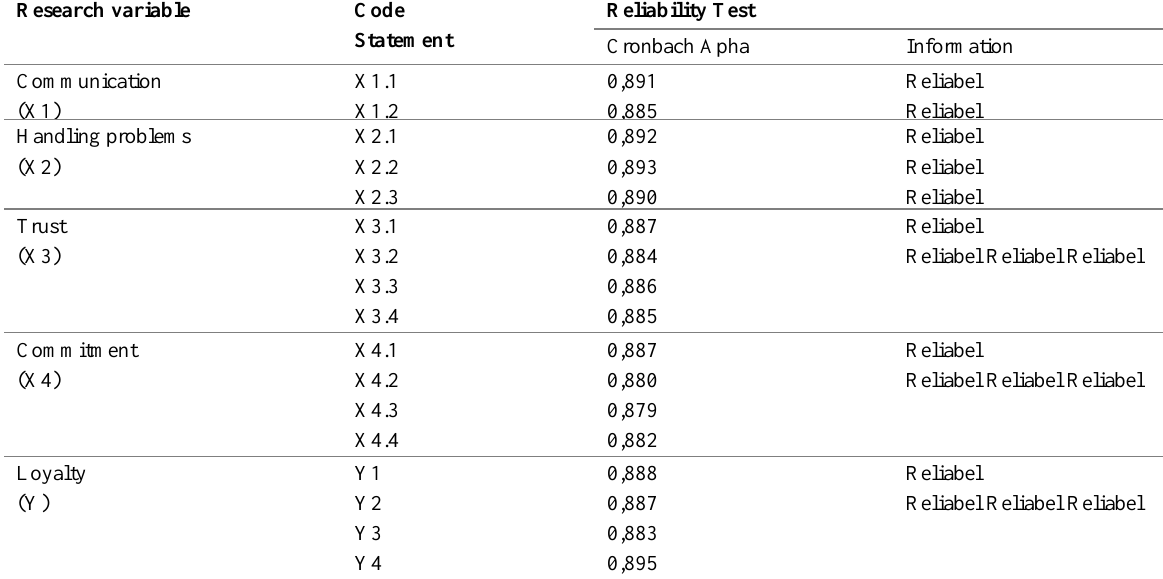
Table 2: Reliability test